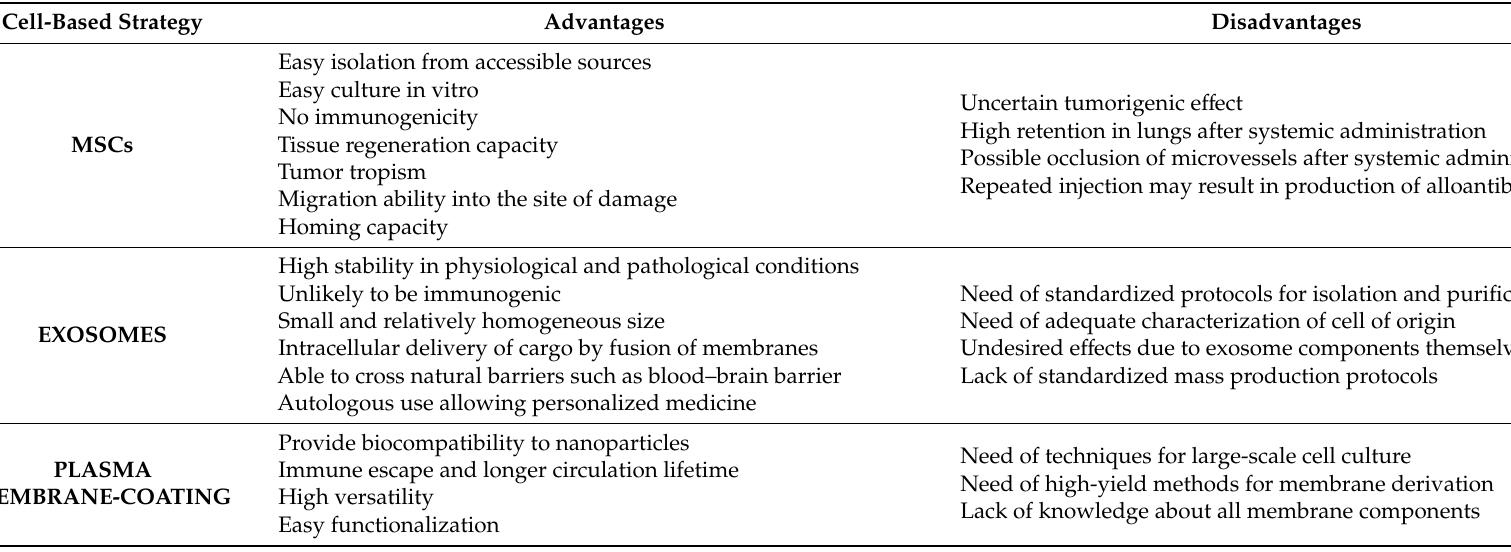
Table 2. Advantages and disadvantages of the di ff erent cell-based delivery